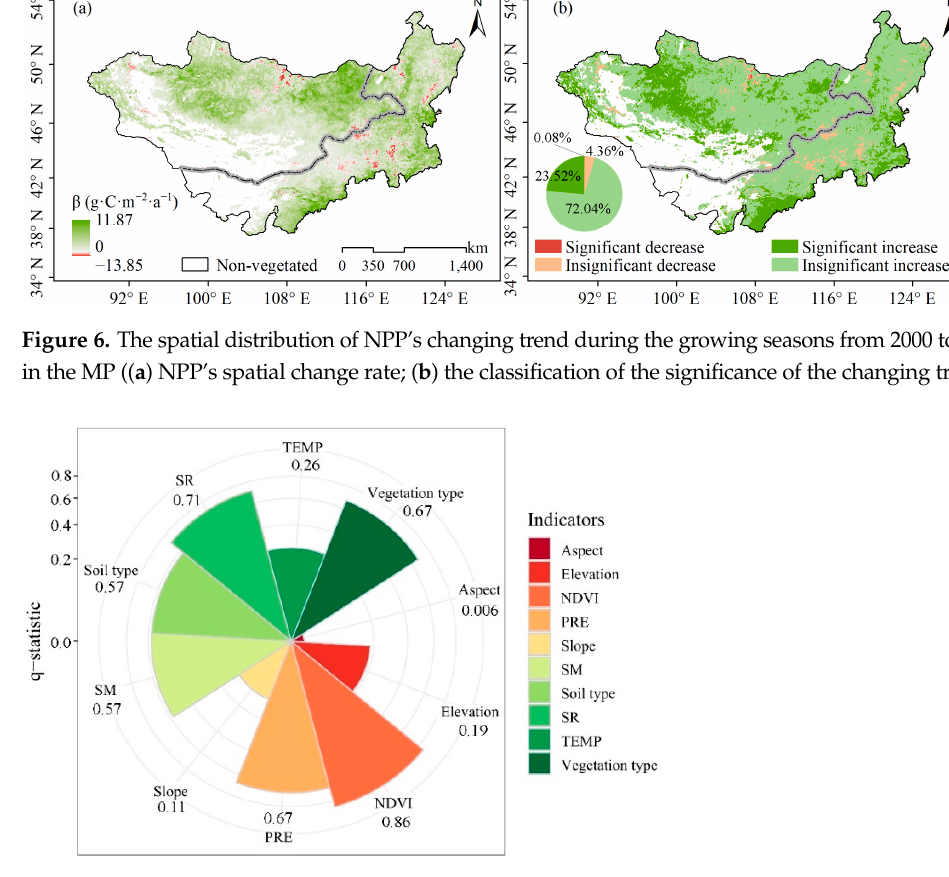
Figure 7. The q-statistics of driving factors in fl uencing NPP’s spatial pa tt ern in the